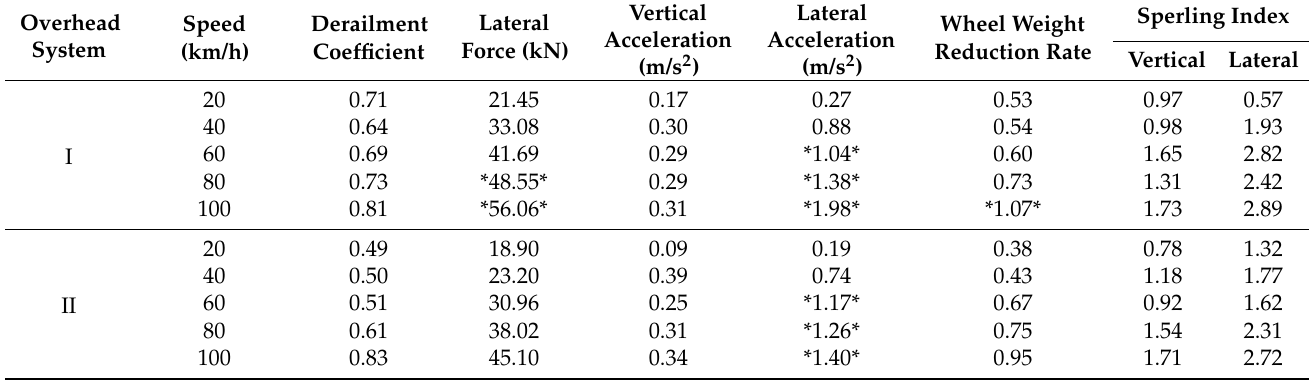
Table 10. Response of trains crossing the bridge at different speeds. (“*” is displayed for any data that do not meet the specifications).